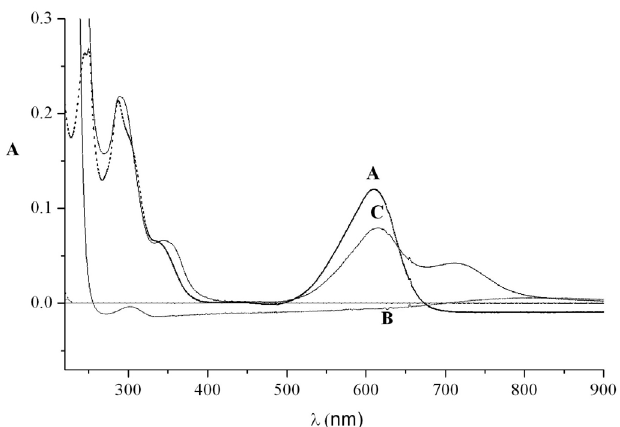
FIGURE 2 - UV-Vis spectra recorded for 1x10 -5 mol L -1 of indigo carmine in aqueous solution ( A ), for 1x10 -3 mol L -1 aqueous solution of Cu(II) ( B ) and after 10 min of mixture of both in aqueous medium ( C ).